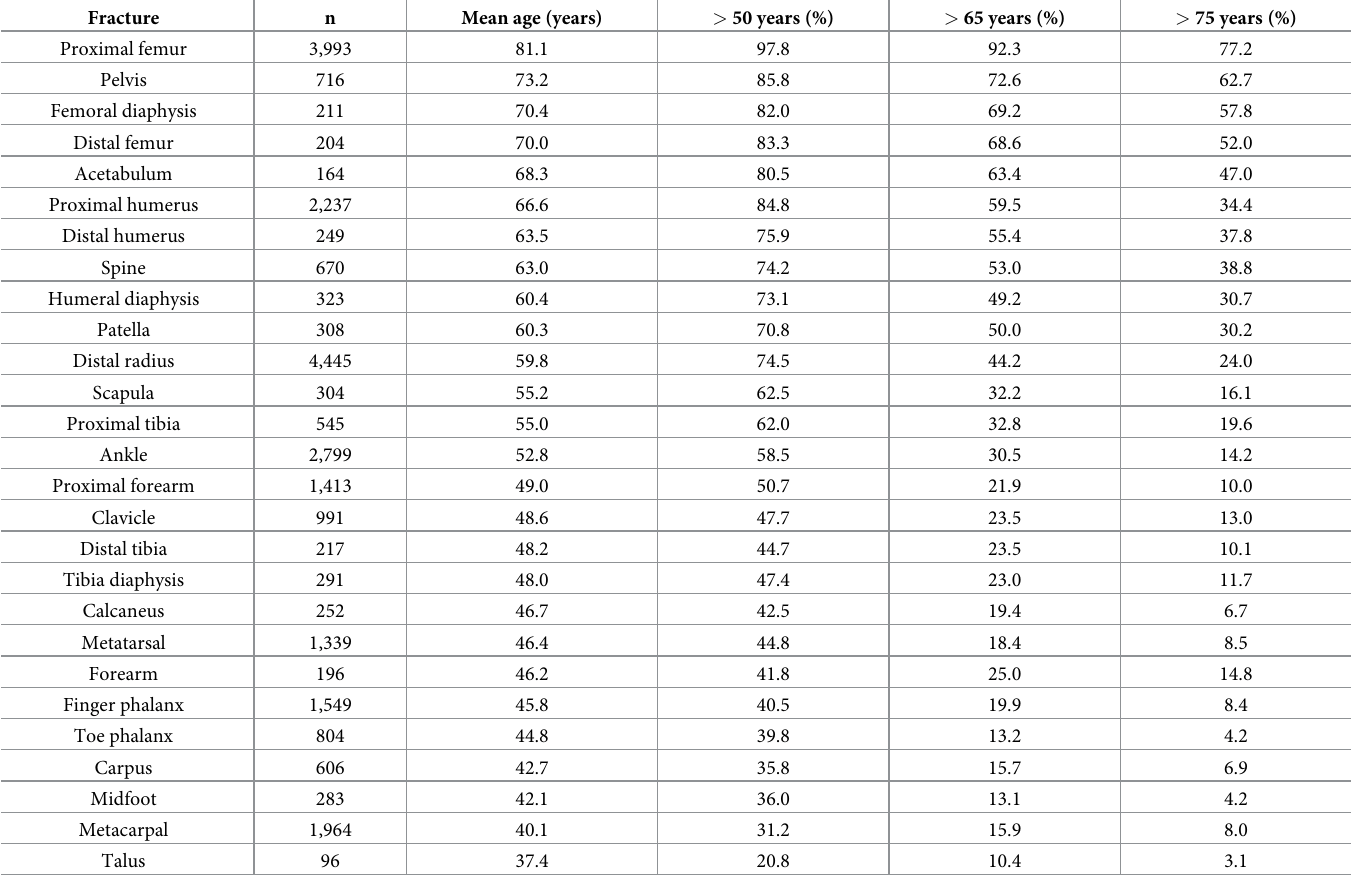
Table 3. Numbers of all fractures, arranged in order of decreasing mean age and with proportion of each of the fracture types in patients over 50, 65, and 75 years of age. Fracture